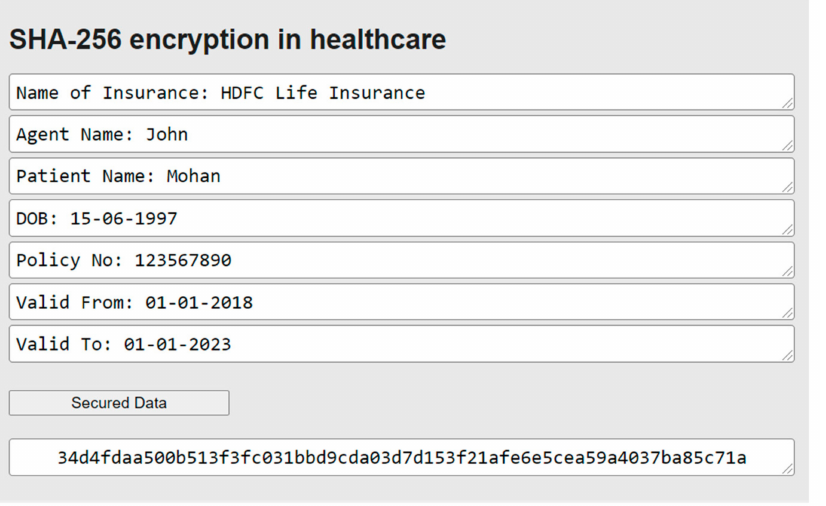
Figure 12. Implementation of the SHA-256 algorithm.